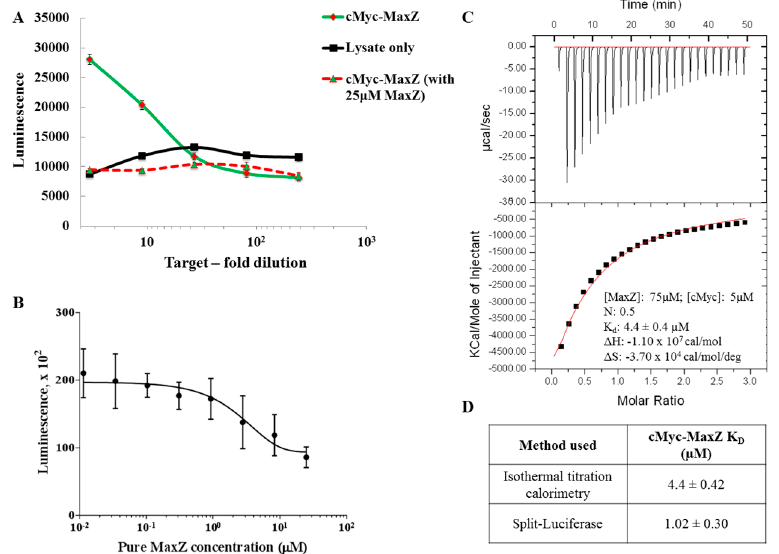
Figure 6. Using split-luciferase assay to determine apparent K D : ( A ): Graphical representation of split-luc assays performed on the cMyc–MaxZ PPI pair. Here, the non-expressing Leishmania tarentolae extract, (LTE) acts as a negative control (in black). To test if the PPI can be disrupted by pure MaxZ, we used 25 µ M MaxZ in conjugation with the PPI pair in the split-luc assay. Here, we do see a reduction in luminescence to the background level, due to presence of pure MaxZ; ( B ): Binding studies of cMyc–MaxZ using purified MaxZ as a PPI disruptor; ( C ): iTC titration curve for cMyc–MaxZ titration where 75 µ M MaxZ was titrated in 5 µ M cMyc and ‘one set of site’ fitting was used to fit the data to get a K D of 4.4 µ M; ( D ): Table comparing the binding constants for cMyc–MaxZ using iTC and split-Luc assay.